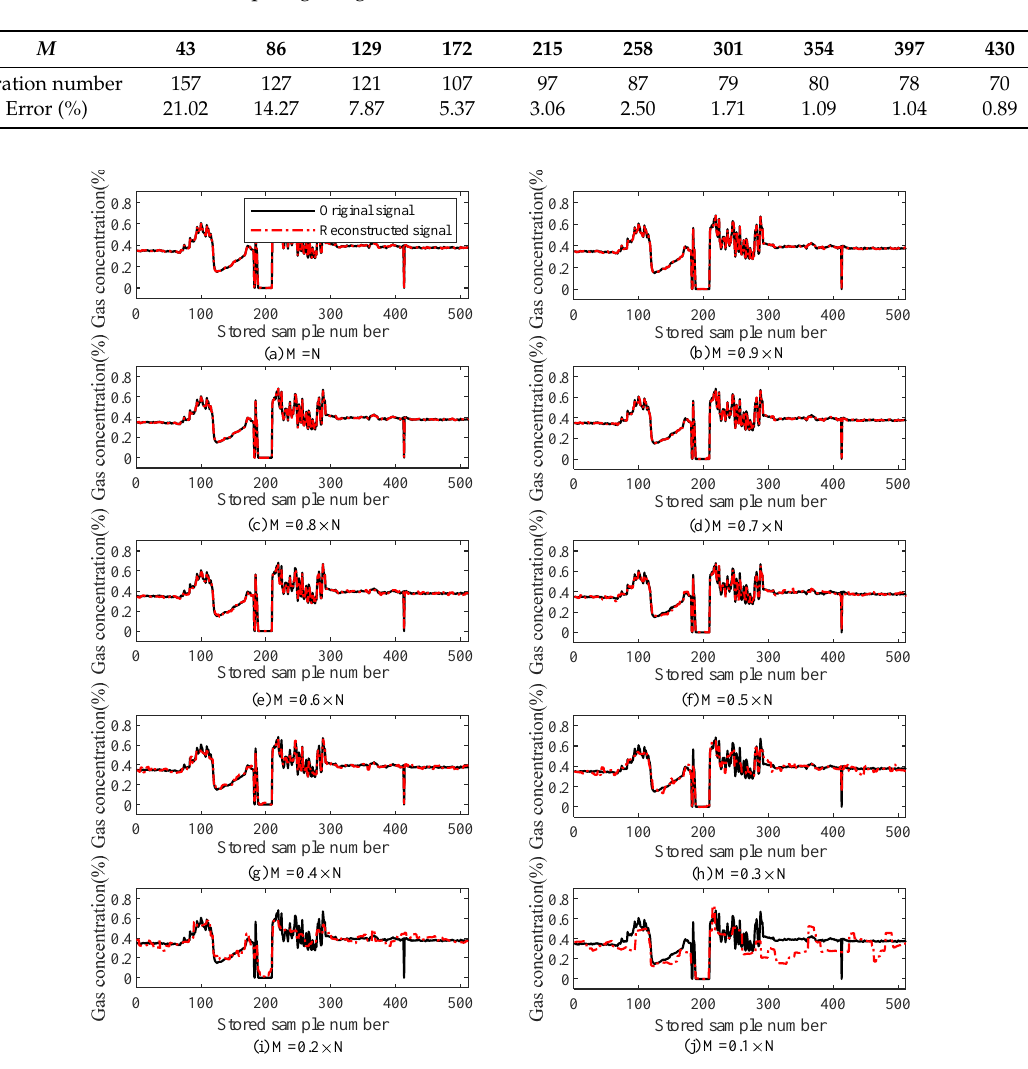
Figure 8. Compression perception and the reconstruction error of the complex gas signal (TVS ‐ MH).